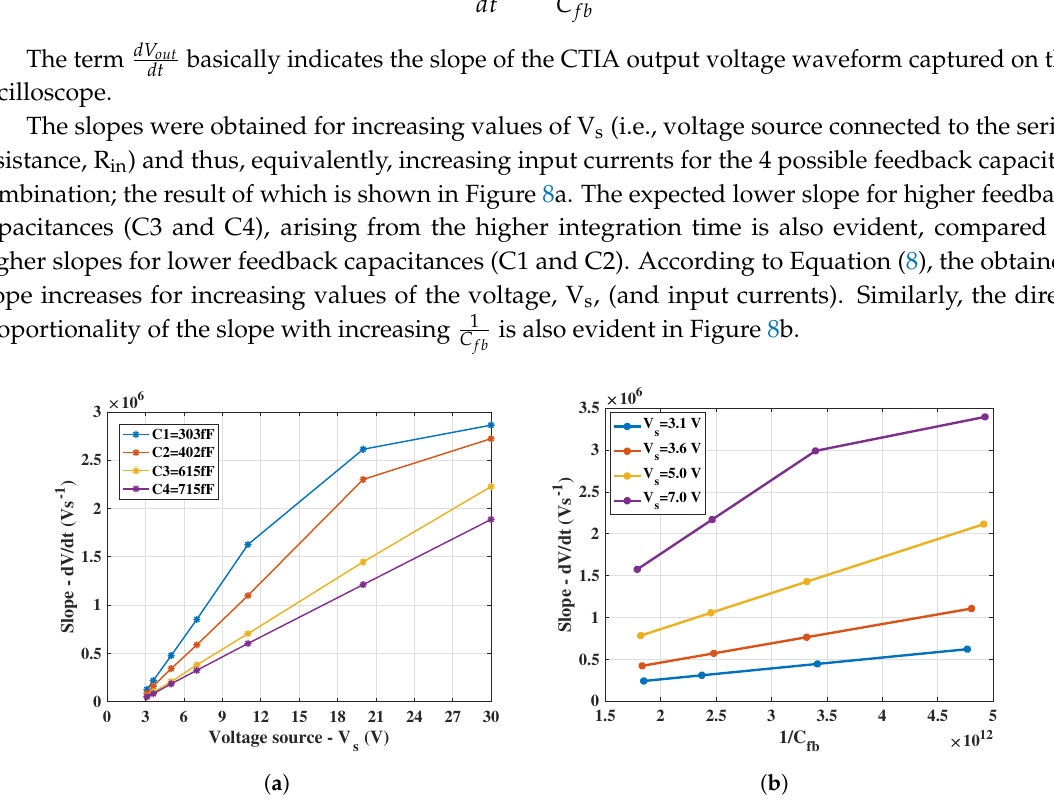
Figure 8. CTIA transient behavior: ( a ) slope versus voltage source, V s ; and ( b ) slope versus 1/C fb